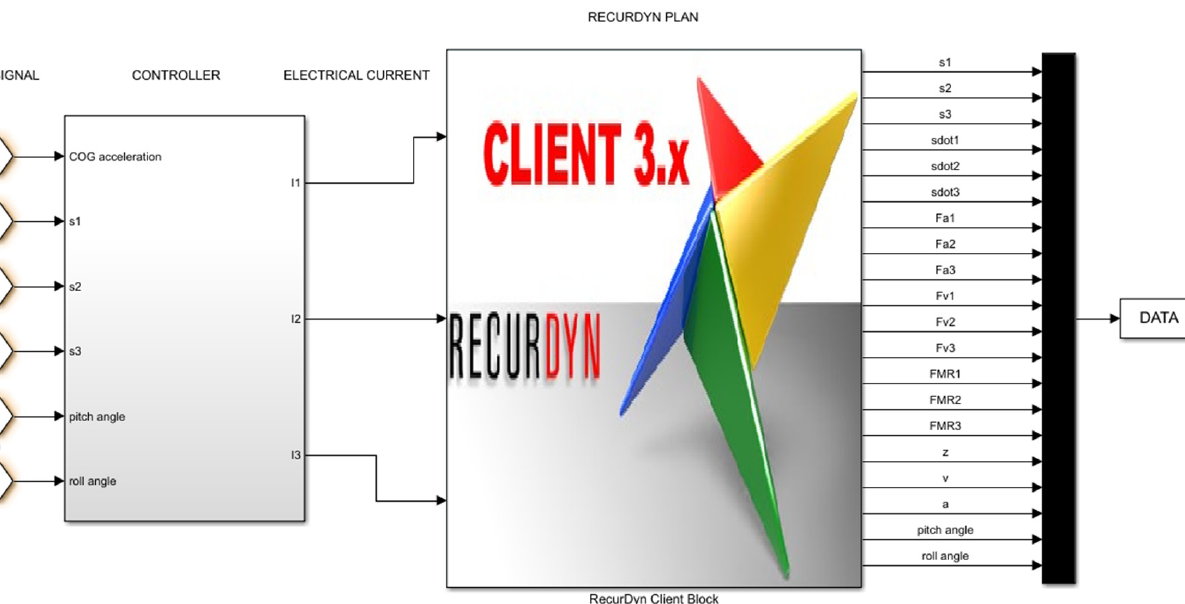
Figure 13. The simulation setup at θ = 7 ° and Φ = 7 ° . ( a ) Front view; ( b ) Side view.